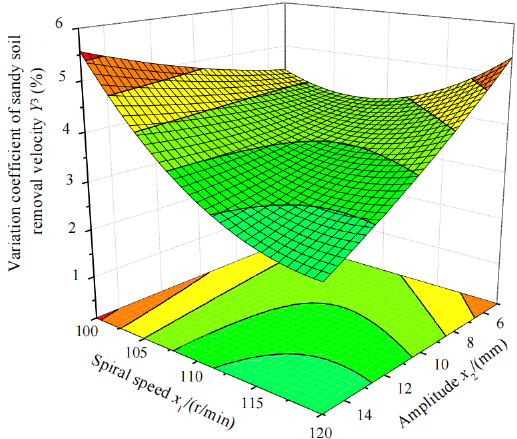
Figure 14. Influence of factor interaction on sandy soil removal rate.